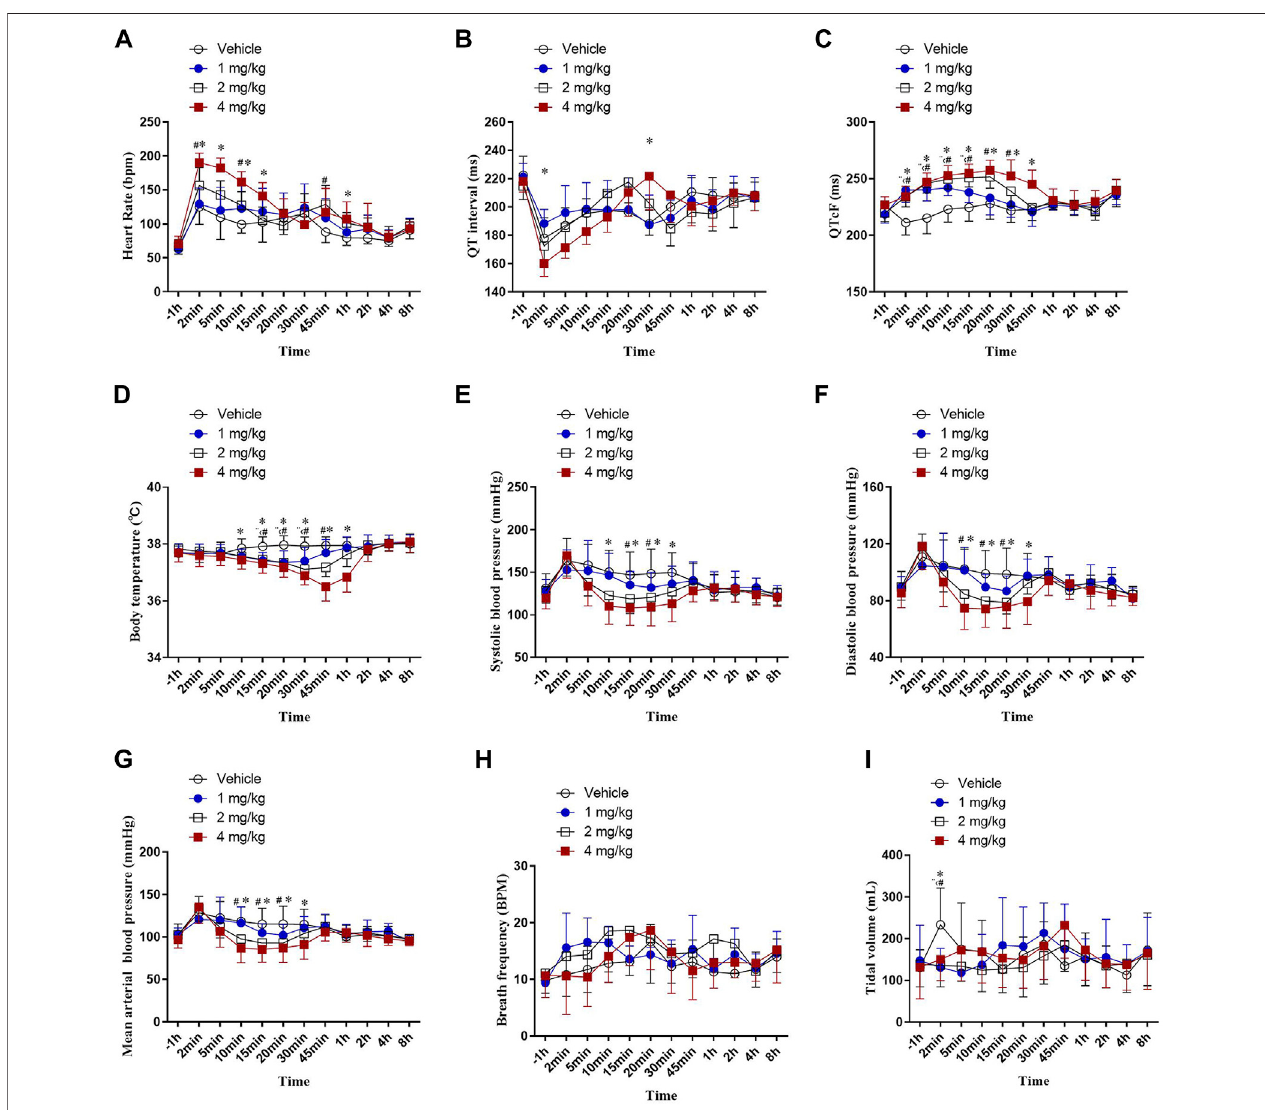
FIGURE4 | Telemetry measurementsafter bolus injection of HSK3486 or propofol in beagle dogs ( n = 8). (A) Heartrate. (B) QT interval. (C) QTc interval. (D) Body temperature. (E) Systolic blood pressure. (F) Diastolic blood pressure. (G) Mean arterial pressure. (H) Respiratory frequency. (I) Tidal volume.